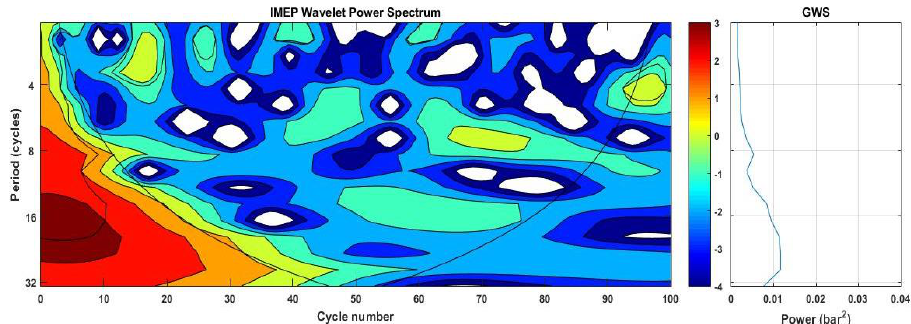
Figure 7. Wavelet analysis of IMEP (WPS and GWS), 10MPa_240BTDC_1800_Foul.